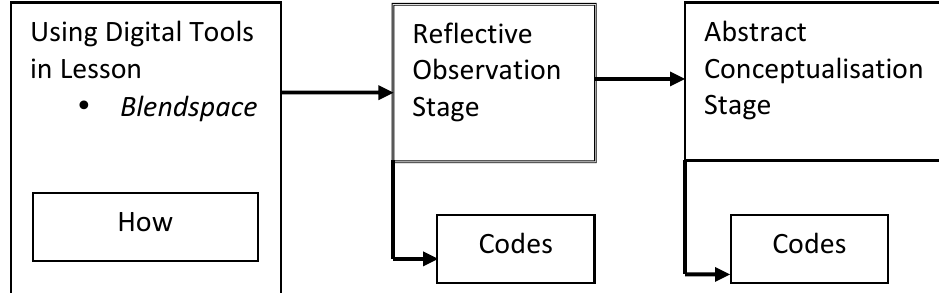
FIGURE 4: Data analysis by using Individual-Logic Model adapted from Yin